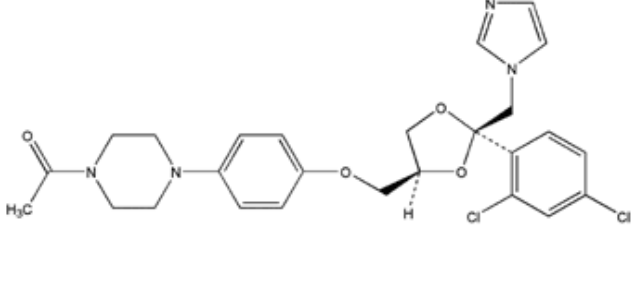
FIGURE 5 . Chemical structure of